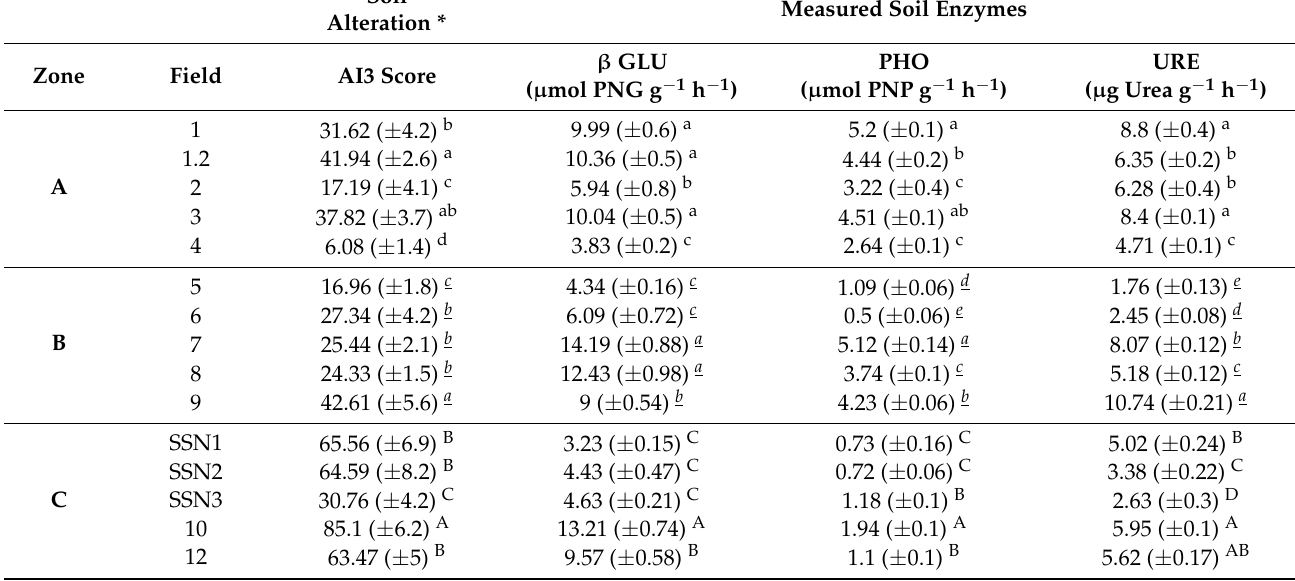
Table 3. Measured enzyme activity of β -glucosidase ( β GLU), phosphatase (PHO), and urease (URE) in fields, divided by zones (standard error of the means is indicated within parentheses); significance letters are formatted as a, a , A according to each zone and each diversity indicator; the letter after the parentheses indicates a statistical significance of p ≤ 0.05 by LSD test in ANOVA, by zones and enzymes. * Soil alteration is defined as in Puglisi et al. [47]).